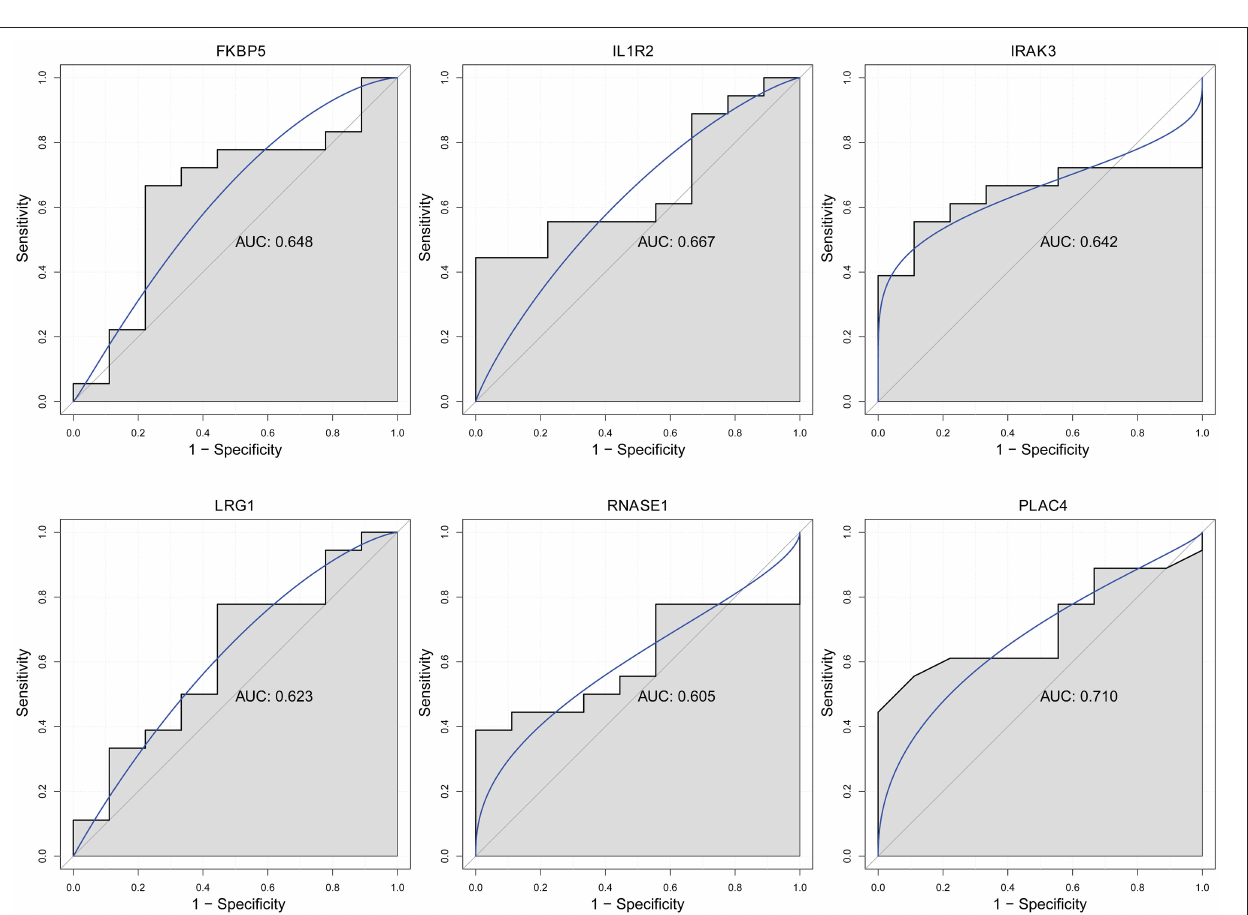
FIGURE 6 | The box plot of FKBP5, IL1R2, IRAK3, and LRG1 in GSE21125 of the HF dataset. Ns, no significant difference.